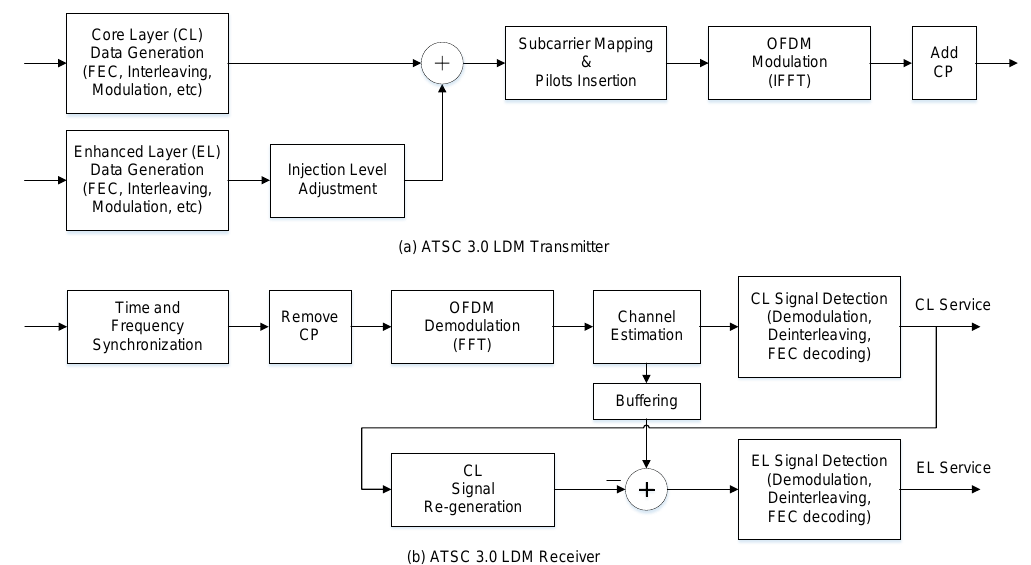
Figure 1. The two-layer layered division multiplexing ( LDM ) transmitter and receiver of the traditional Advanced Television System Committee (ATSC) 3.0 system: ( a ) two-layer LDM transmitter; ( b ) two-layer LDM receiver.